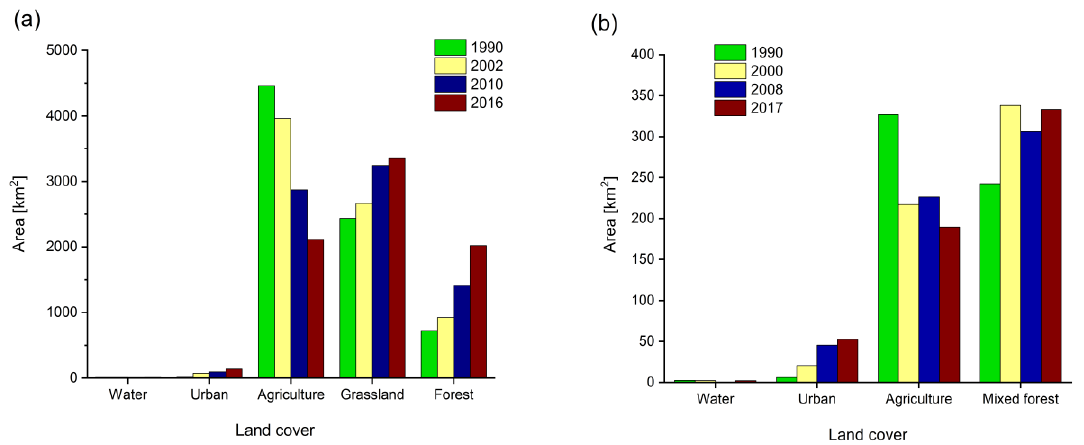
Figure 4. Area covered by each LULC class over 1990–2016 / 2017 for the Yanhe ( a ) and Guangyuan ( b ) watersheds.